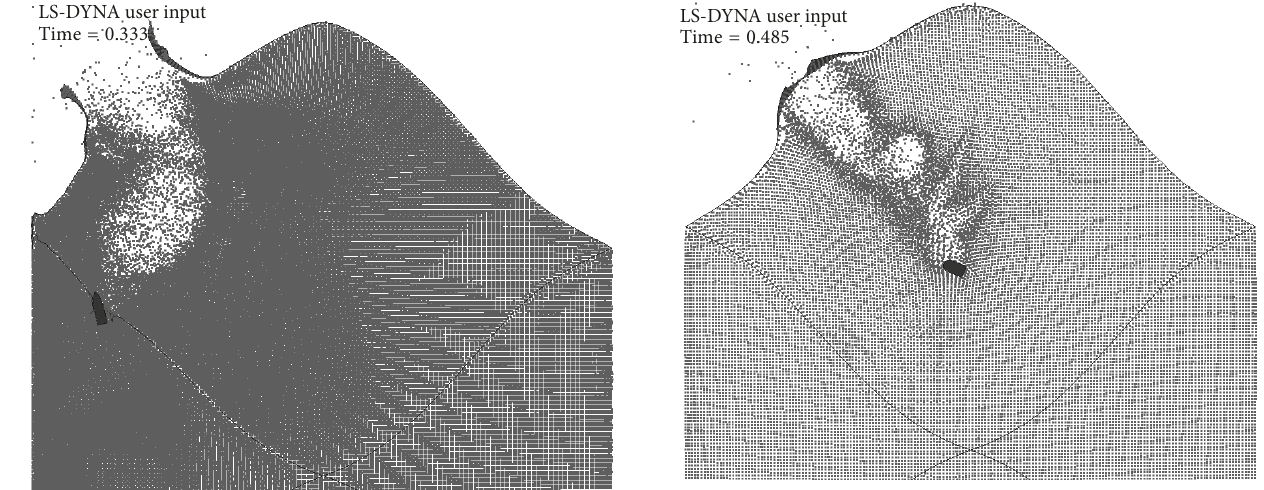
Figure 19: Penetration from off-axis by SCRB.